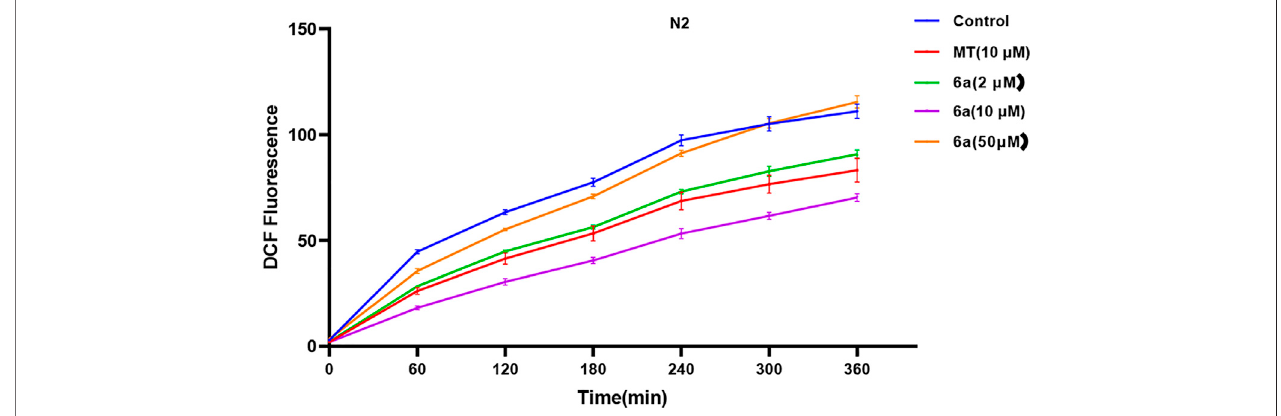
FIGURE 3 | Effect of 6a on the ROS level in wild-type.